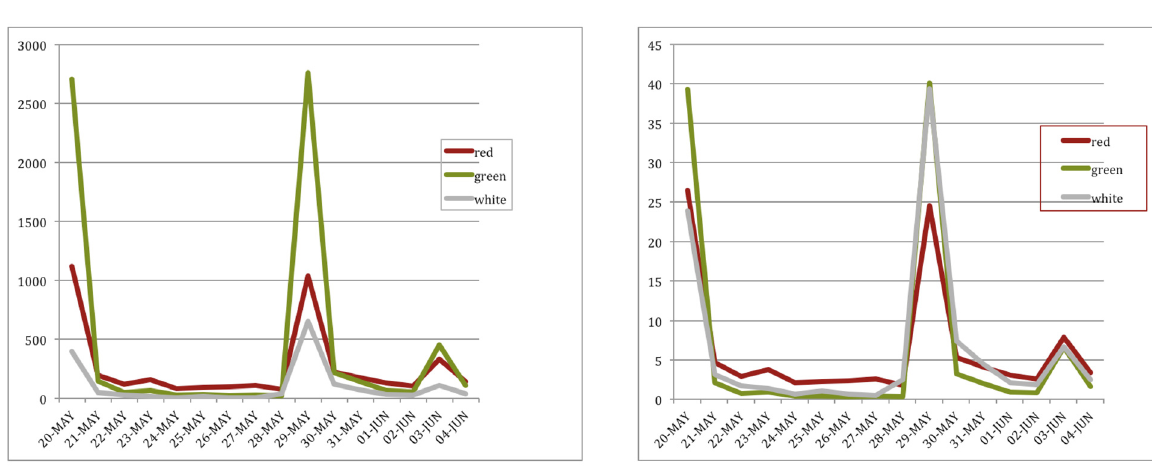
Figure 5. Number of tweets over time (whole database, in the 3 zones of Figure 1).